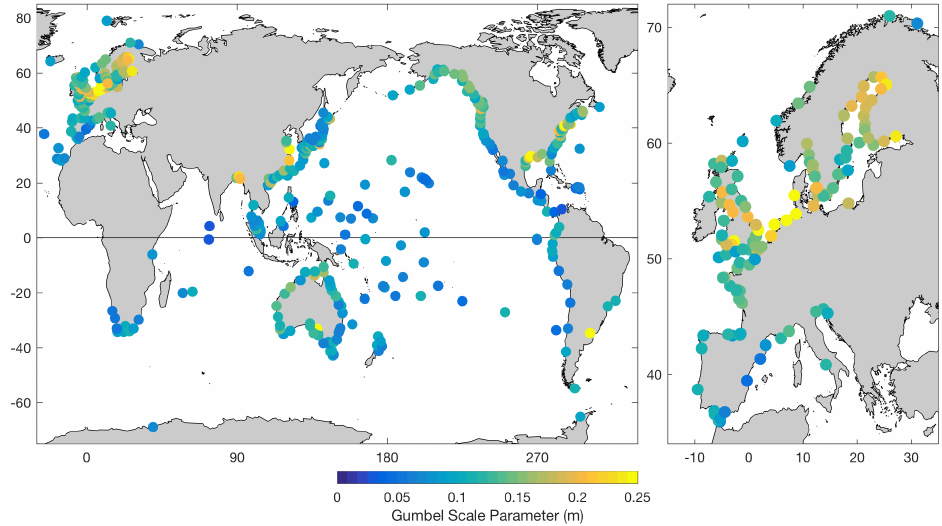
Figure 3. ( left ) Gumbel scale parameters (m) at 652 tide gauge stations and ( right ) a zoom on the European